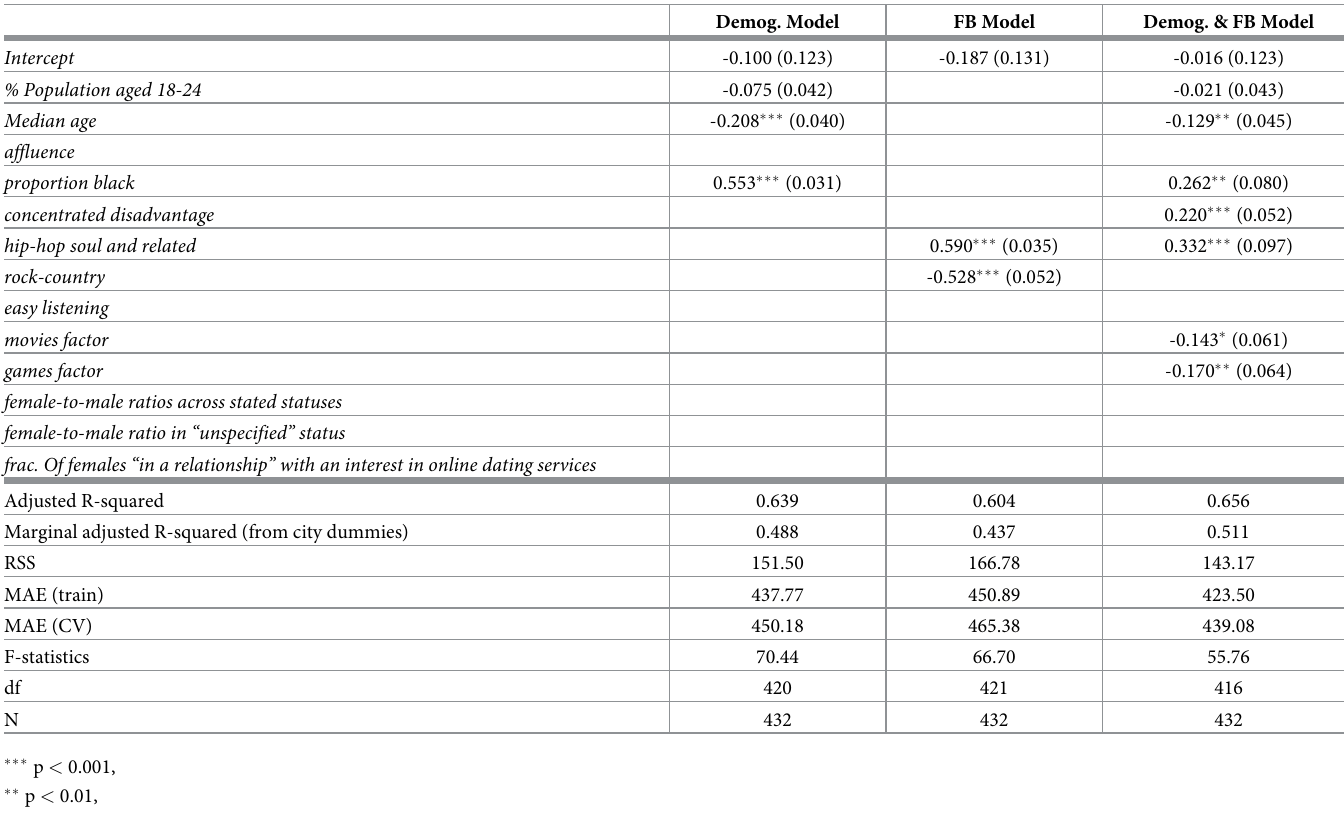
Table 3. Parameter estimates and fit statistics for regression models predicting assault